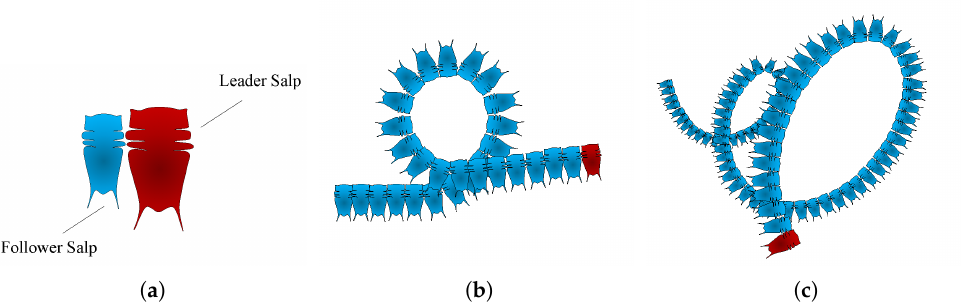
Figure 4. Salps in deep ocean environment ( a ) single salp, ( b ) and ( c ) salps swarms or salps